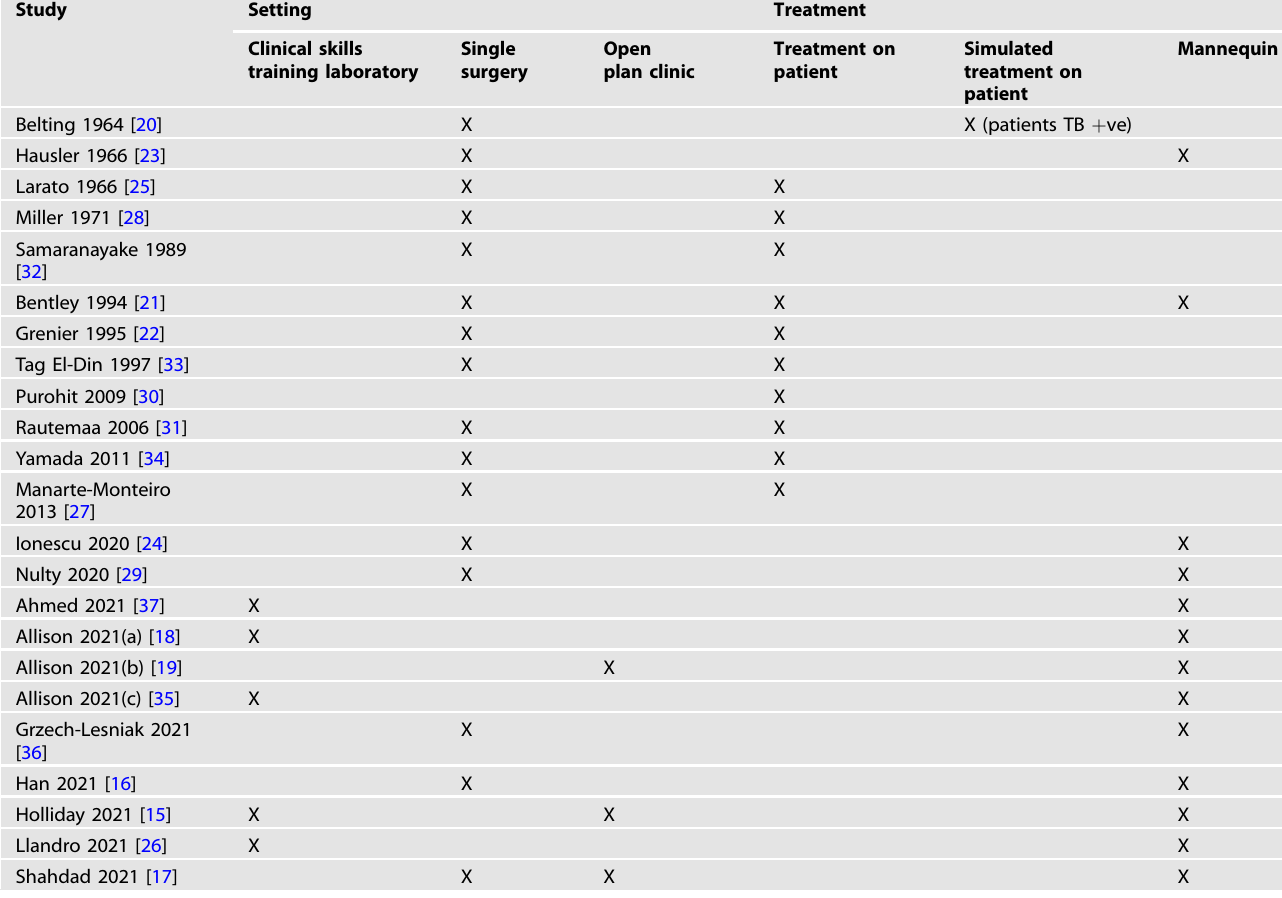
Table 1. Study setting